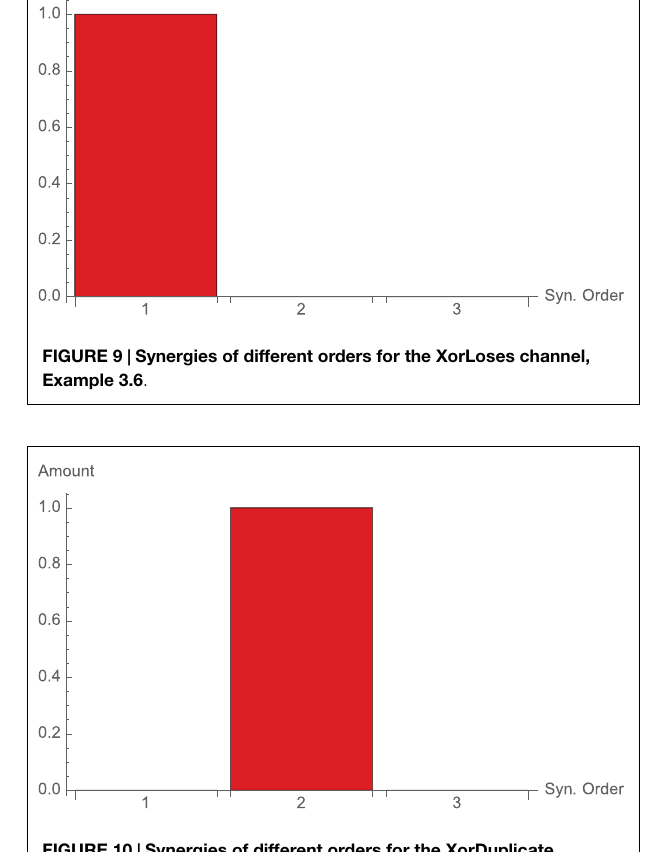
FIGURE 10 | Synergies of different orders for the XorDuplicate channel, Example 3.7